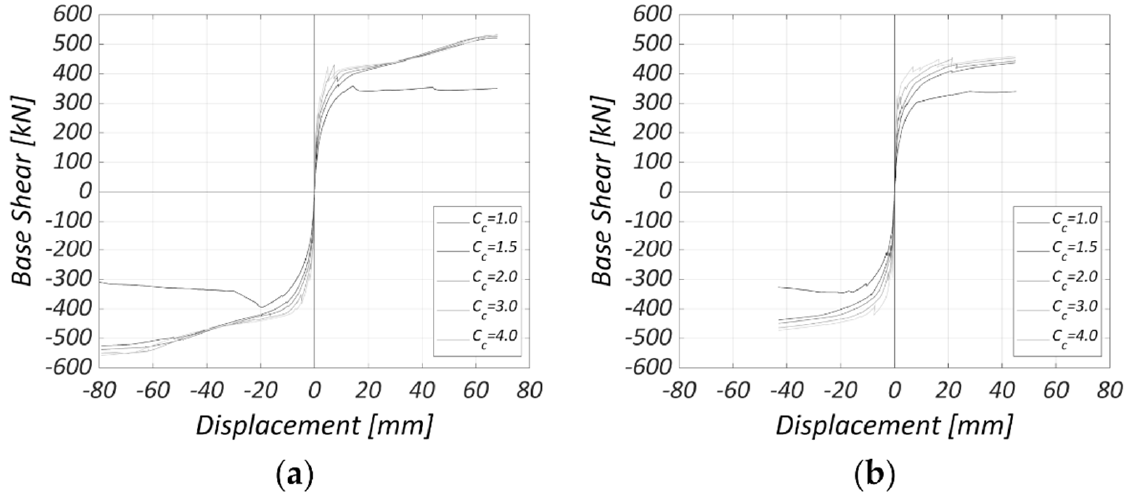
Figure 16. Comparison between pushover curves obtained with various correction coefficients including masonry tensile strength: ( a ) Building 2; ( b ) and Building 3.